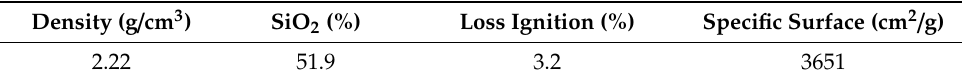
Table 3. Properties of fly ash.